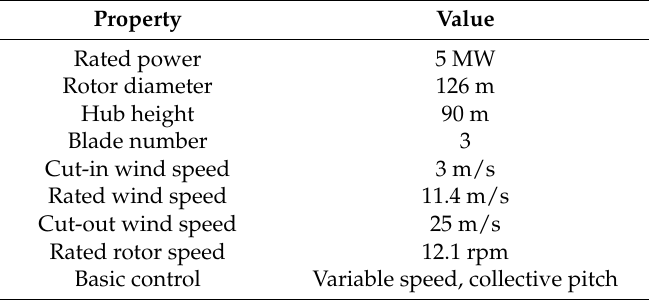
Table 1. The 5 MW reference wind turbine specifications.